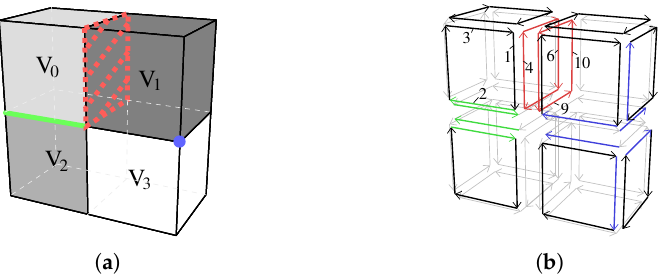
Figure 1. ( a ) A 3D mesh composed of 4 cubes, V 0 , V 1 , V 2 , V 3 , two by two adjacent; ( b ) The corresponding 3-map having 96 darts (24 for each cube) where some darts are